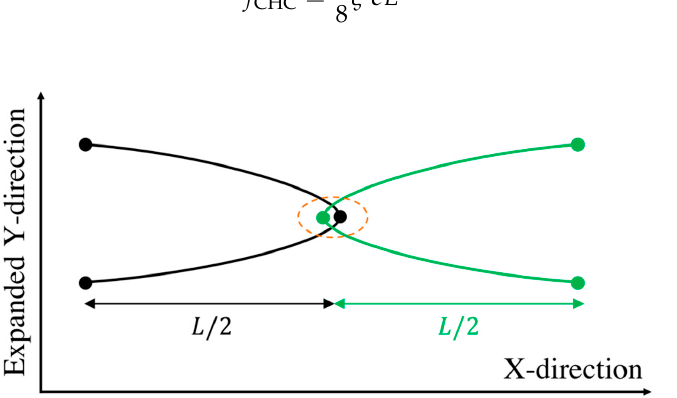
Figure 4. The ‘center-hooked’ configuration between two chains entangled at the center of each chain. The Y-direction is arbitrarily expanded for clarity.